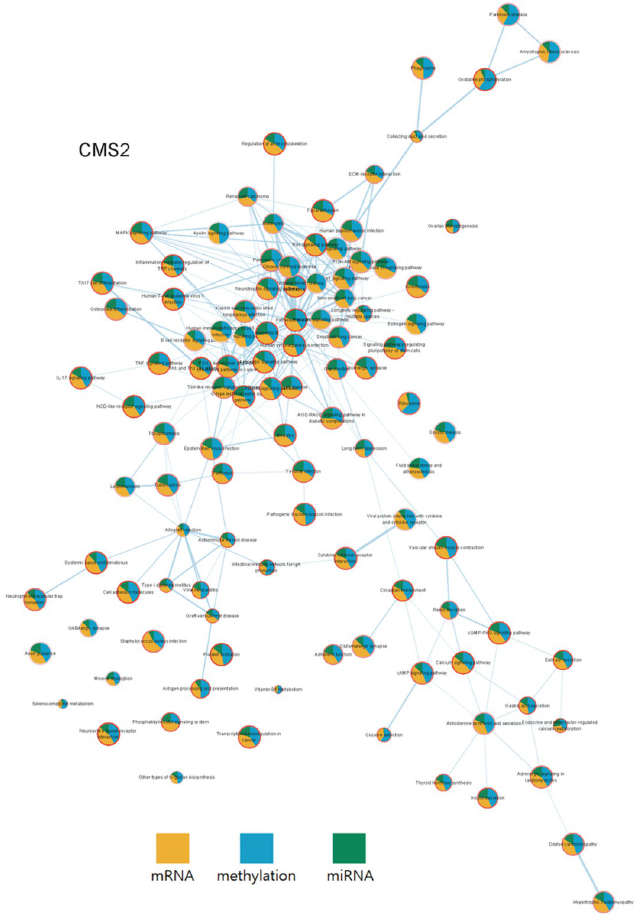
Fig 13. The pathway networks of COAD CMS2. Here, each node represents a pathway, where the pie chart indicates the OCR and the border the survival p-value. Each edge represents how many genes are shared within each pathways (node). The OCR values according to each group were visualized from the COAD